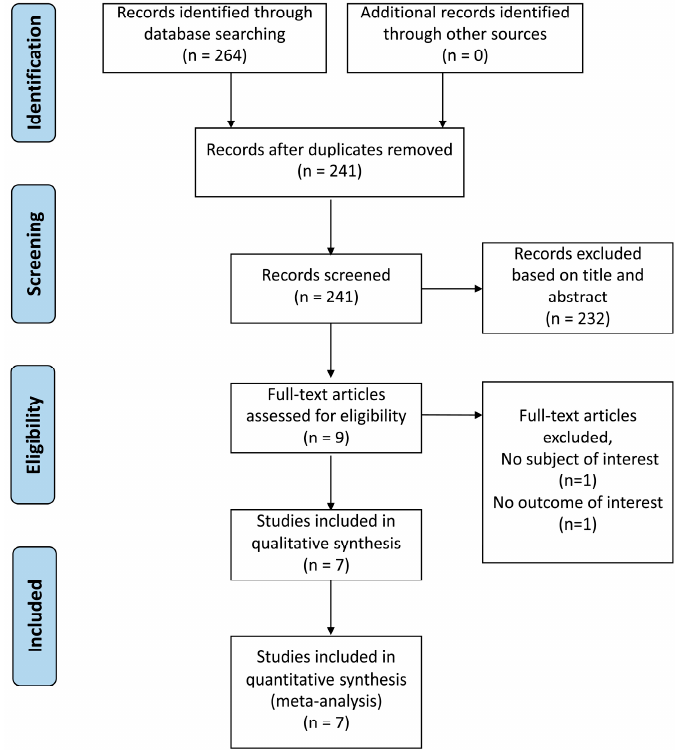
Figure 1. Flow diagram of the study selection process.